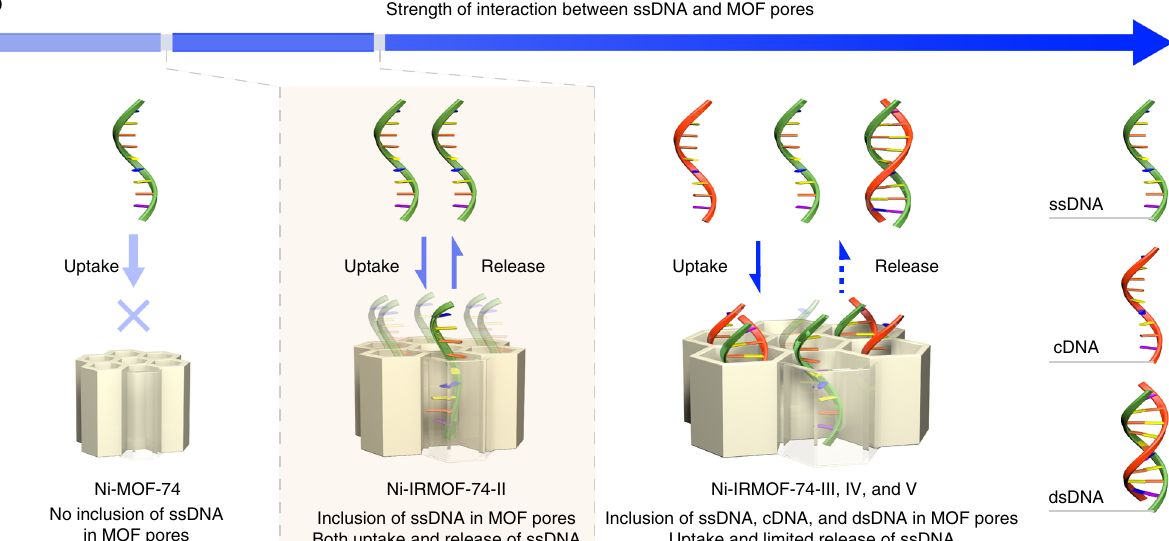
520 nm. When the labeled ssDNA entered the pores, FAM motifs were brought so close to the walls of the framework that electrons can be transferred from FAM to the MOFs which resulted in fl uorescence quenching (Fig. 2a and Fig. 3a). Such phenomenon was not observed in the control experiment using the FAM molecule without linking to ssDNA (Supplementary Figure 58). The signi fi cant fl uorescence quench of the FAM-labeled ssDNA inside the pores of these MOFs, and this allows for accurate quanti fi cation of ssDNA uptake as re fl ected by the exact fl uor-